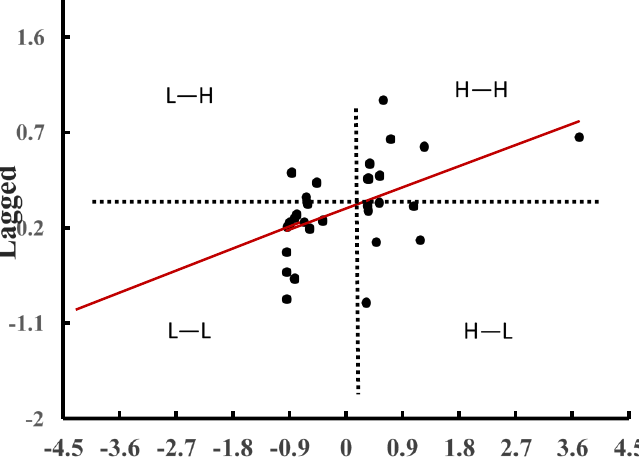
Figure 4. Moran’s I scatter chart of provincial forestry ecological efficiency (FEE) cluster in 2018.